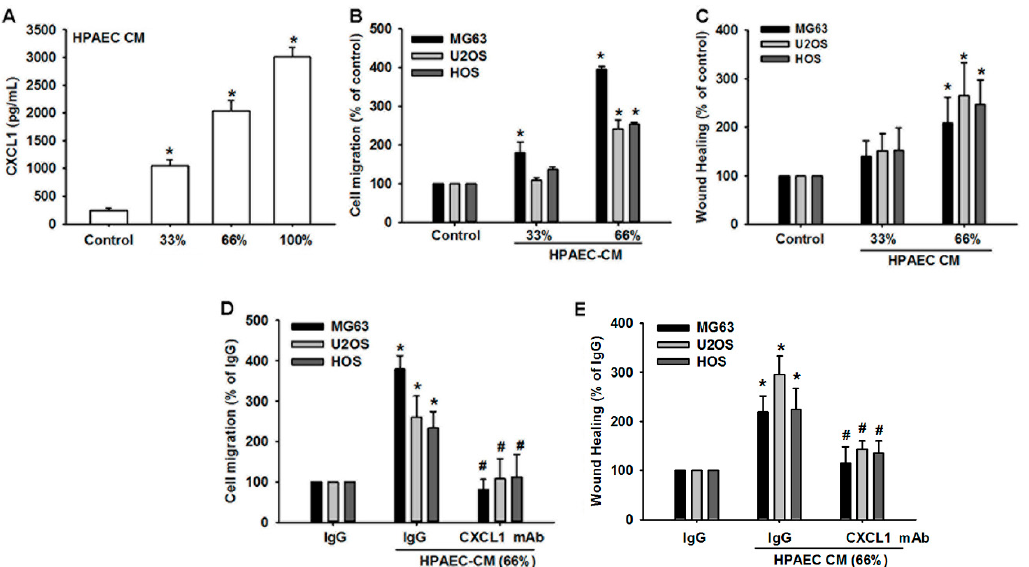
Figure 3. Human pulmonary artery endothelial cell (HPAECs)-secreted CXCL1 promotes migration of osteosarcoma cells. ( A ) HPAECs conditioned media (CM) was collected and levels of CXCL1 secretion were determined by ELISA. ( B ) HPAECs CM was placed in the lower chamber of the Transwell plate. MG63, U2OS, and HOS osteosarcoma cells were seeded in the upper chamber of the Transwell plate and cell mobility was determined after 20 h. ( C ) Osteosarcoma cells were incubated with the indicated concentrations of HPAECs CM for 24 h. Cell mobility was assessed by a wound healing assay. ( D ) HPAECs CM was placed in the lower chamber of the Transwell apparatus in the presence of CXCL1 neutralizing antibody or control IgG (1 μ g/mL). MG63, U2OS, and HOS osteosarcoma cells were seeded in the upper chamber of the Transwell apparatus and cell mobility was determined after 20 h. ( E ) Osteosarcoma cells were incubated with the indicated concentrations of HPAECs CM in the presence of CXCL1 neutralizing antibody or control IgG for 24 h. The cells were subjected to wound healing assays to assess cell mobility. Results are expressed as the mean ± SD. * p < 0.05 compared with control or the control IgG group. # p < 0.05 compared with the HPAECs CM-treated group.